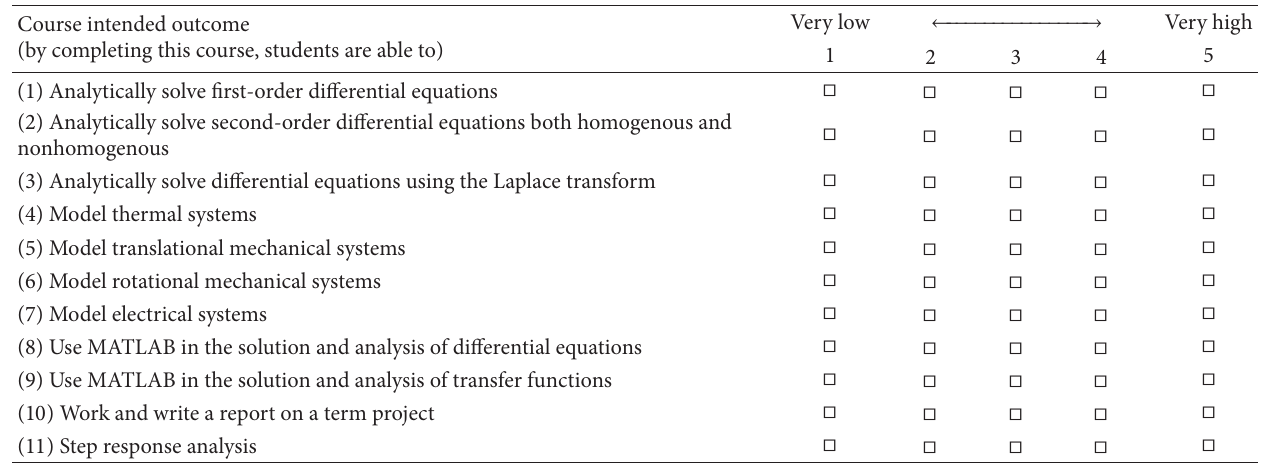
Table 6: Sample for the indirect assessment students’ survey used in the course MATH2210-differential equations and engineering applications.